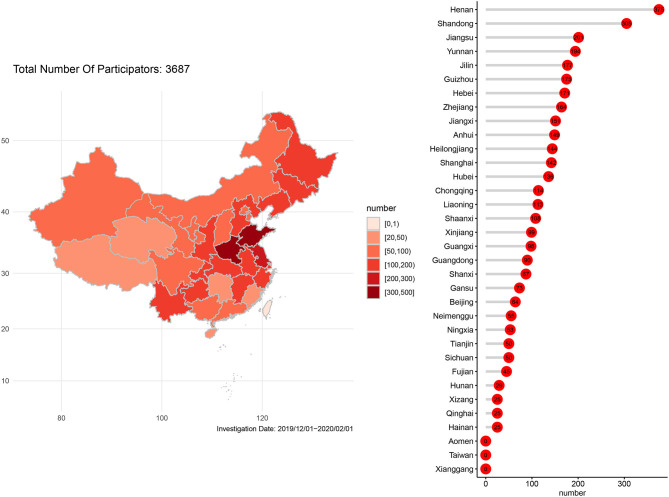
Geographical distribution of participants in China.